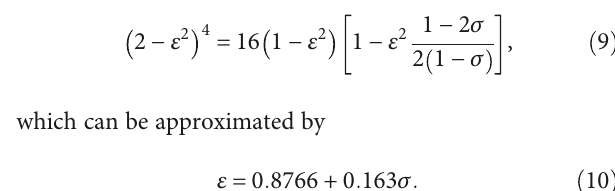
Figure 2: Size distributions of particle samples: (a) samples S lognormal